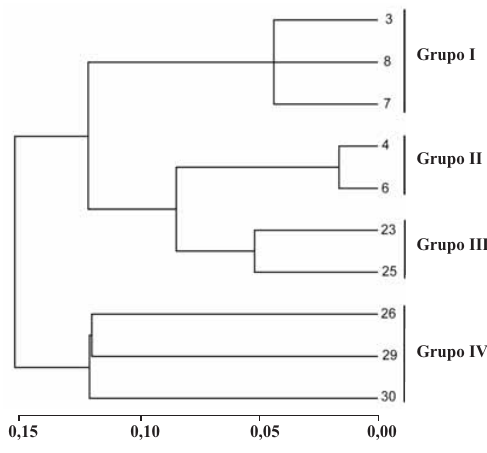
Figura 4. Dendrograma de similaridade, mostrando a relação entre os valores de F das comunida- ST des de bactérias diazotróficas endofíticas de di- ferentes regiões climáticas do Rio Grande do Sul. Os valores de F foram significativamente di- ST ferentes a 0,05, usando mil